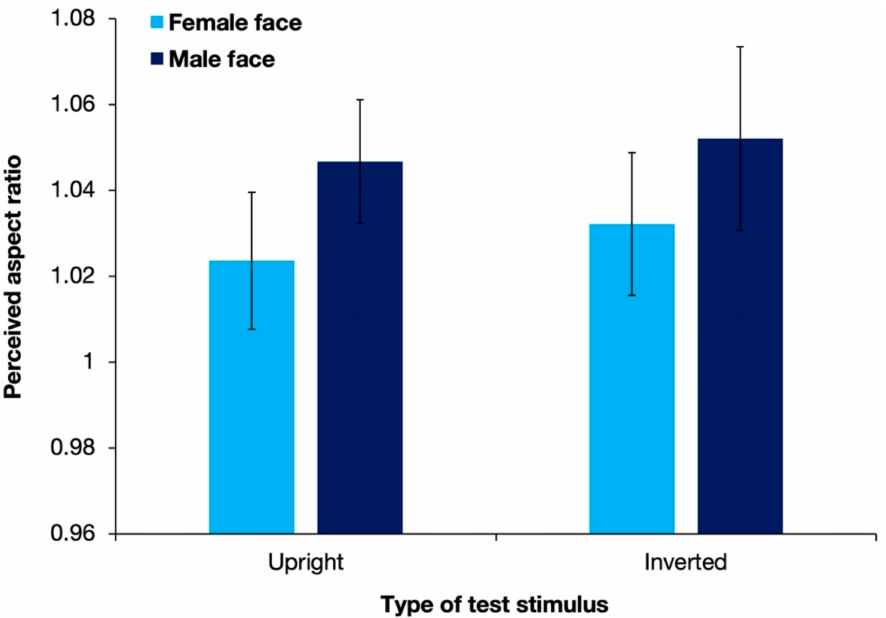
Figure 5. Results of the mean perceived aspect ratios of response circles averaged over 17 observers in Experiment 2. Error bars denote standard errors of the mean. Stimuli with a male face evoked a significantly stronger shape-contrast effect than stimuli with a female